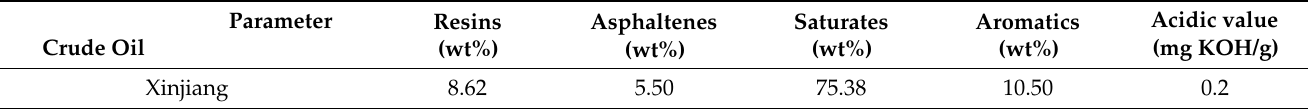
Table 2. Four-component contents and acidic value of Xinjiang crude